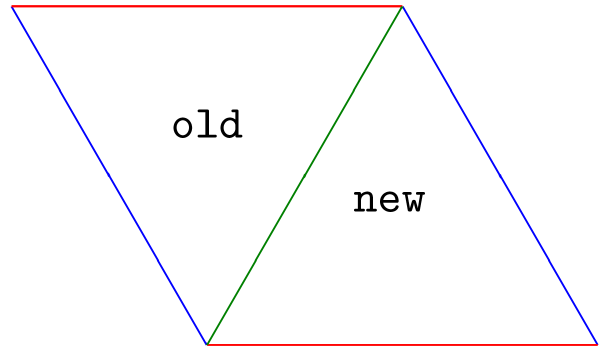
Figure 7. Illustration of how to color the edges of a newly visited cell (right) based on the edge colors of an old cell (left).